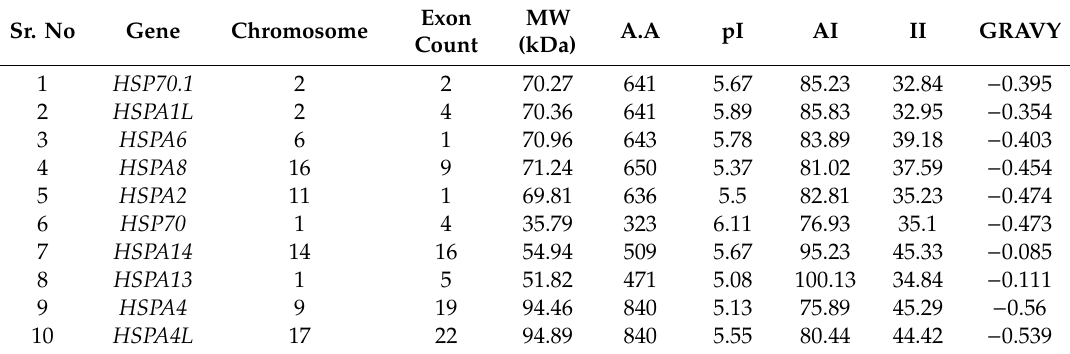
Table 1. Physiochemical Properties of HSP70 gene family